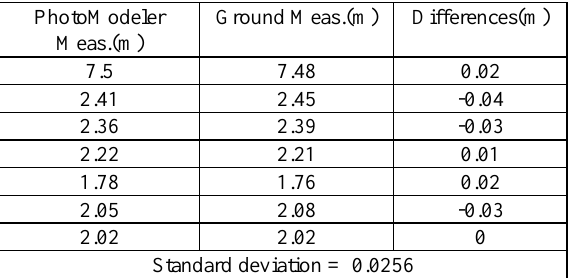
Table 1. Comparing different results of hand measuring and close-range photogrammetry, Calculation of standard